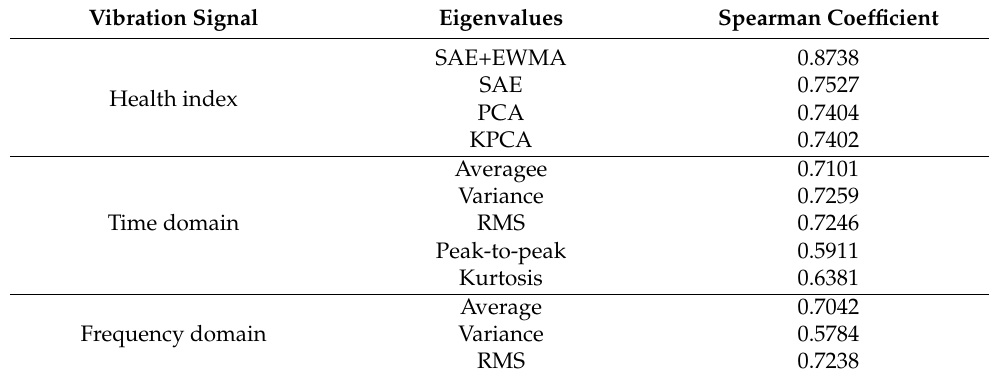
Table 3. Correlation between characteristic indicators and